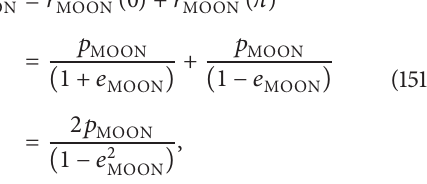
𝑀 , which is the intersection of the direct line